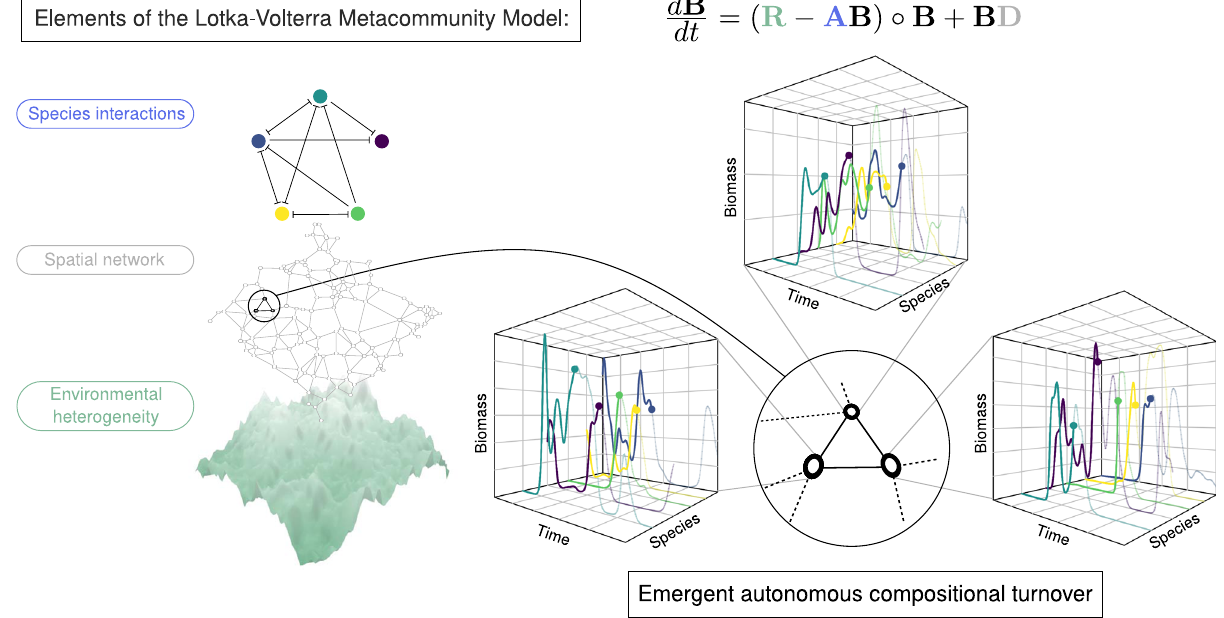
Fig. 1 Elements of the Lotka-Volterra metacommunity model and the emergence of autonomous population dynamics. Environmental heterogeneity, represented by the intrinsic growth rate matrix R , is modelled using a spatially autocorrelated Gaussian random fi eld. A random spatial network, represented by the dispersal matrix D , de fi nes the spatial connectivity of the landscape. The network of species interactions, represented by the competitive overlap matrix A , is modelled by sampling competition coef fi cients at random (perpendicular bars indicate recipients of a deleterious competitive impact). The resulting dynamics of local population biomasses, given by the colour-coded equation, are numerically simulated. The Hadamard product ‘ ∘ ’ represents element-wise matrix multiplication. For large metacommunities, local populations exhibit persistent dynamics despite the absence of external drivers. In the 3D boxes, typical simulated biomass dynamics of dominating species are plotted on linear axes over 2500 unit times. The graphs illustrate the complexity of the autonomous dynamics and the propensity for compositional change (local extinction and